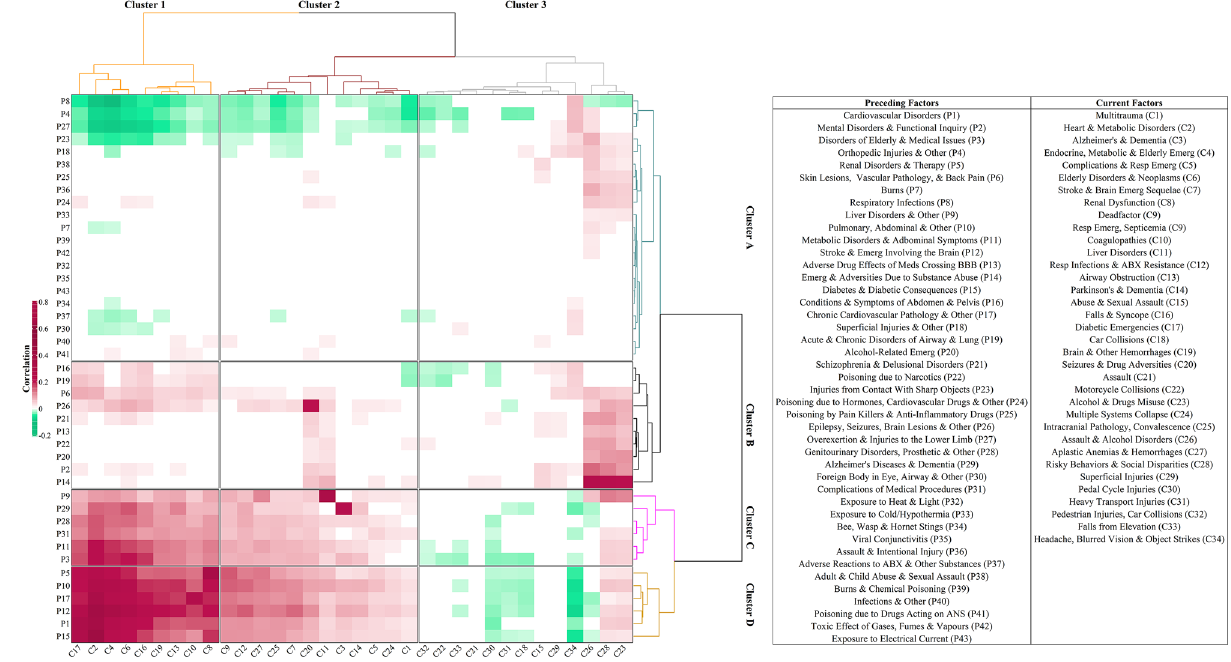
Figure 3. Cluster analysis and heatmap across 43 factors preceding TBI (y-axis) and 34 factors at the TBI event (x-axis). On the left y-axis, preceding injury clusters (Clusters A-D) are annotated for reference with the text. On the upper x-axis, TBI event clusters (Clusters 1–3) are likewise annotated. Annotations are presented as guidelines and are not definitive. Only internally validated factors in the testing and validation datasets are presented. In the heatmap, each colour represents a set of binned ranks in the heatmap, with green colours representing negative correlations and magenta colours representing positive correlations, adjusted for FDR. White fields represent non-significant correlations after adjustment for